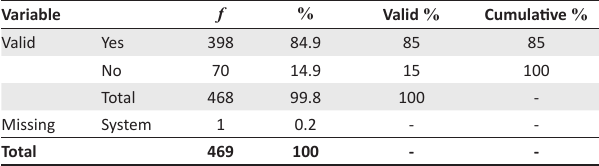
FIGURE 8: Comparative results of placement test results for EDL. TABLE 6: The development of reading skills as perceived by